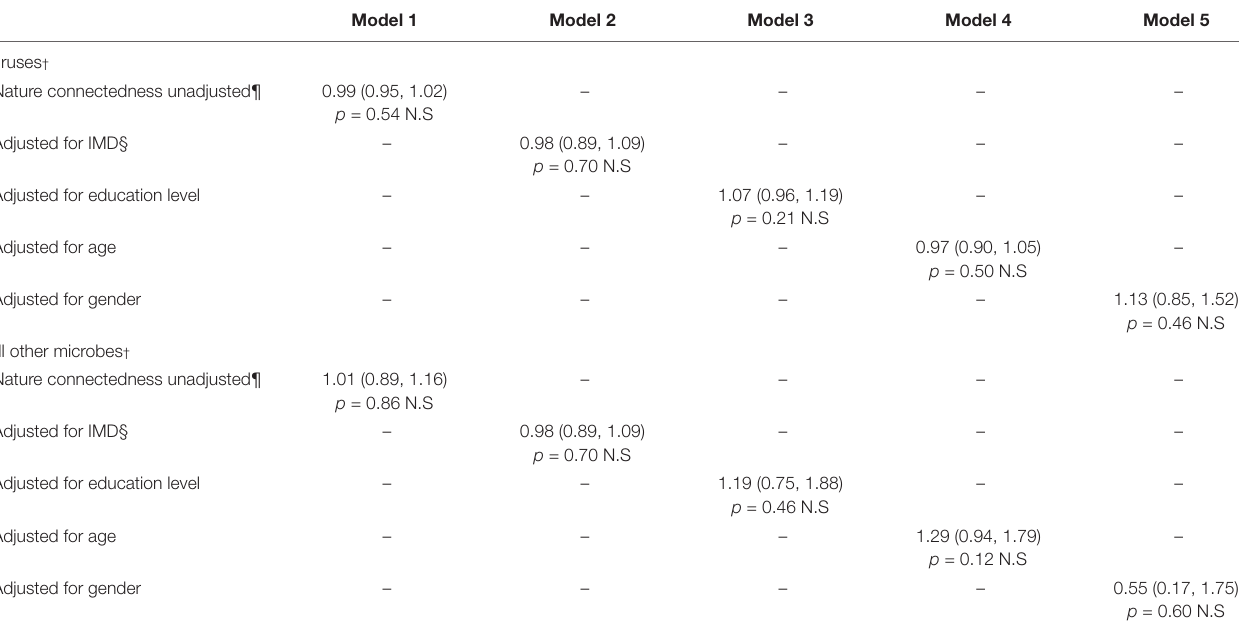
FIGURE 3 | Typical frequency of visits to natural environments per week for respondents with net positive and net negative word-association scores. The yellow diamond represents the mean value. The dashed red line is a visual aid to track the difference in means. TABLE 1 | Associations between attitudes toward microbes and nature connectedness, adjusting for relative deprivation, education, age and